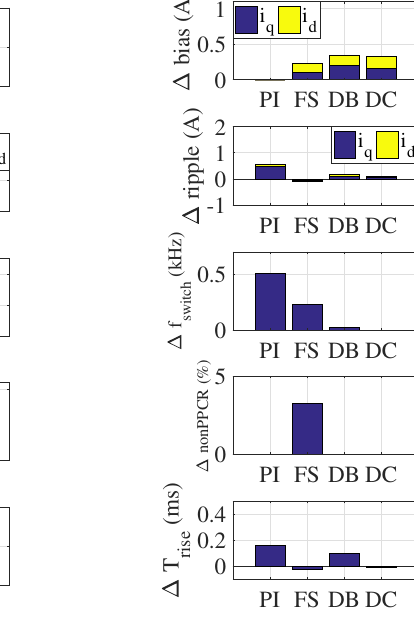
PI FS DB PI FS DB